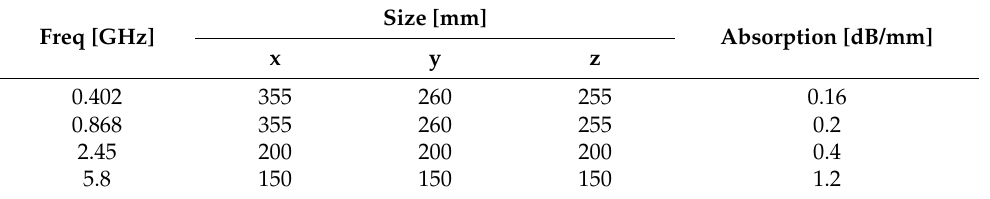
Table 1. Minimum phantom size that reliably represents an entire body for implant communication at a 10 mm to 50 mm insertion depth and corresponding absorption rate.